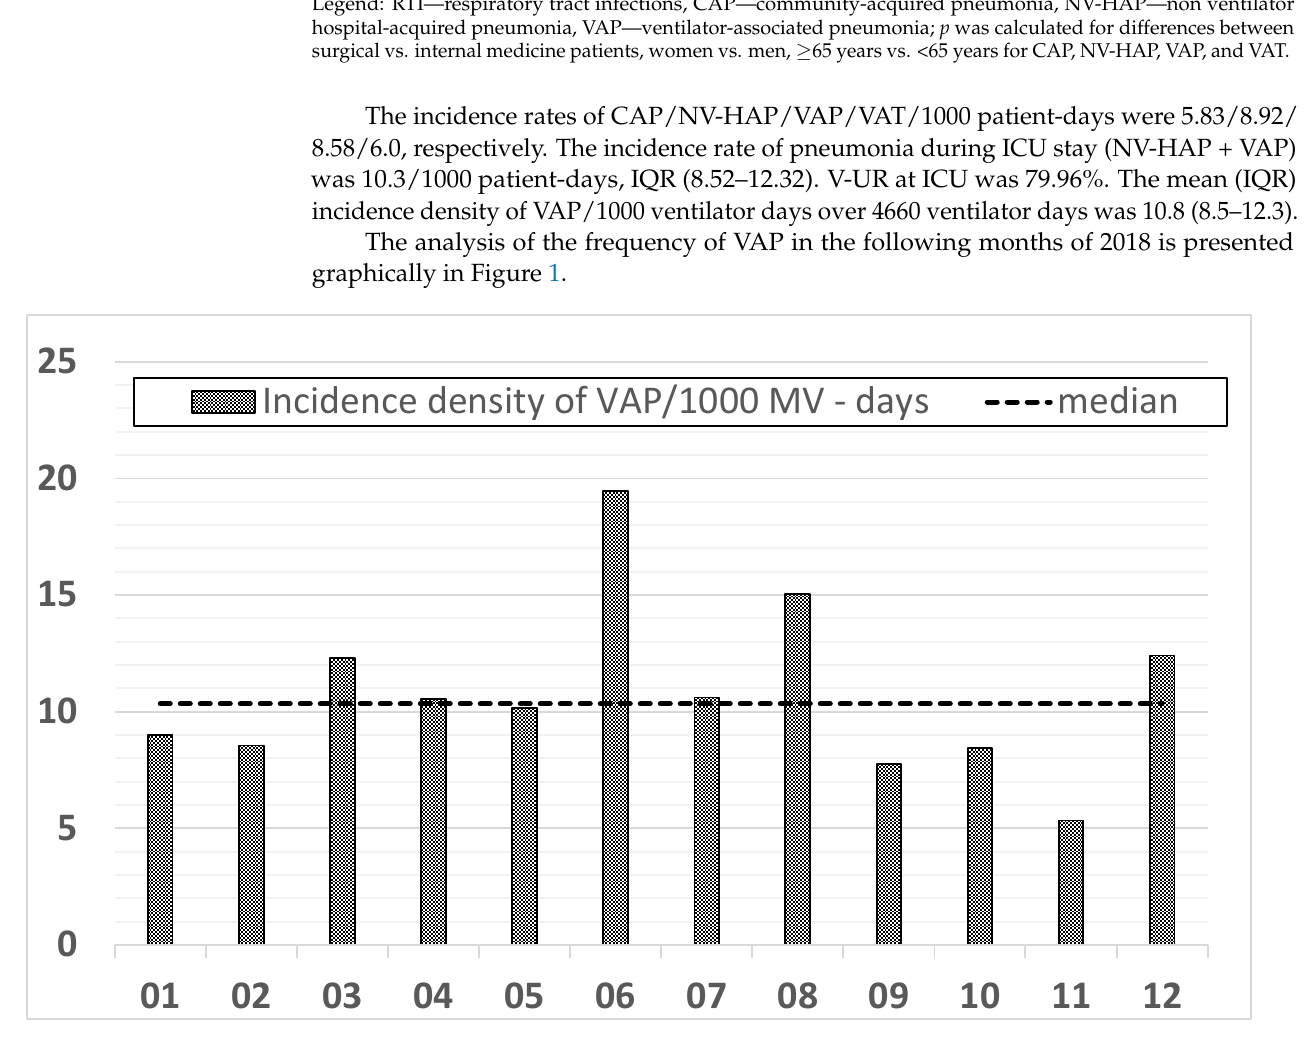
Table 3. Rate of RTIs in terms of gender, age, reasons for hospitalization. Data are presented as number, %, 95% CI.